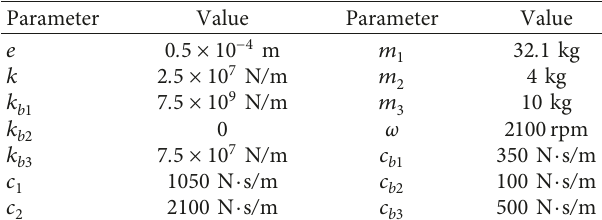
Table 1: Values of the simulation parameters. Parameter